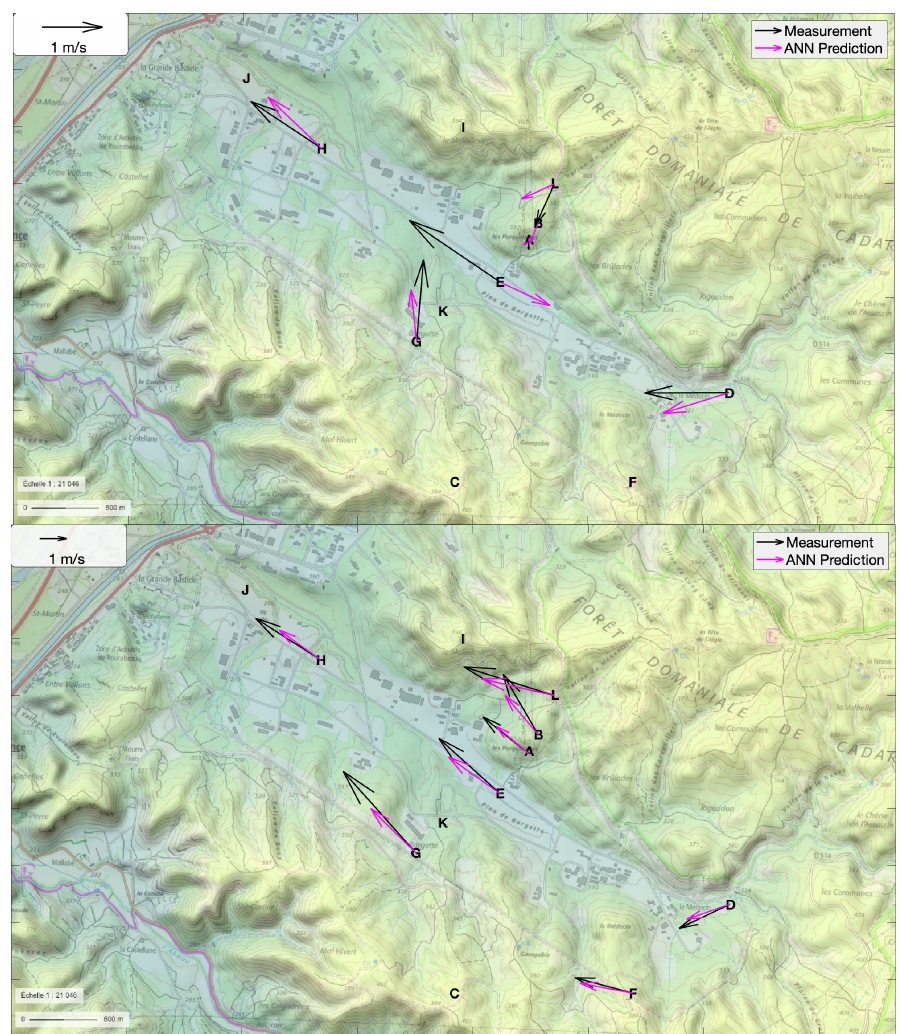
Figure 7. Measured and predicted flow visualization for a single time step in the respective period. The LEMS locations are marked by bold letters. LEMS I, J, and K do not show arrows because they were used for the training data, and LEMS C does not show arrows because it was excluded from this analysis. The ( top ) half of the figure displays an example of a typical thermally driven flow in the Cadarache Valley (17 January 2017 00:15:00 local standard time), and the ( bottom ) half of